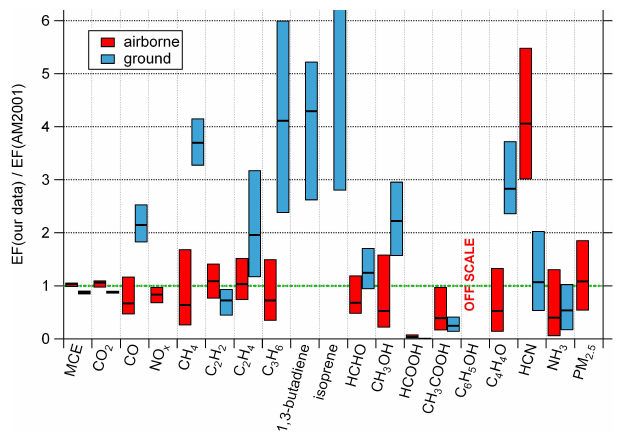
Fig. 5. Comparison of our airborne and ground-based emission factors with the recommendations of Andreae and Merlet (2001) (AM2001). For our data, the upper and lower bounds of the bars represent the range of our data, while the line inside the bar repre- sents the average